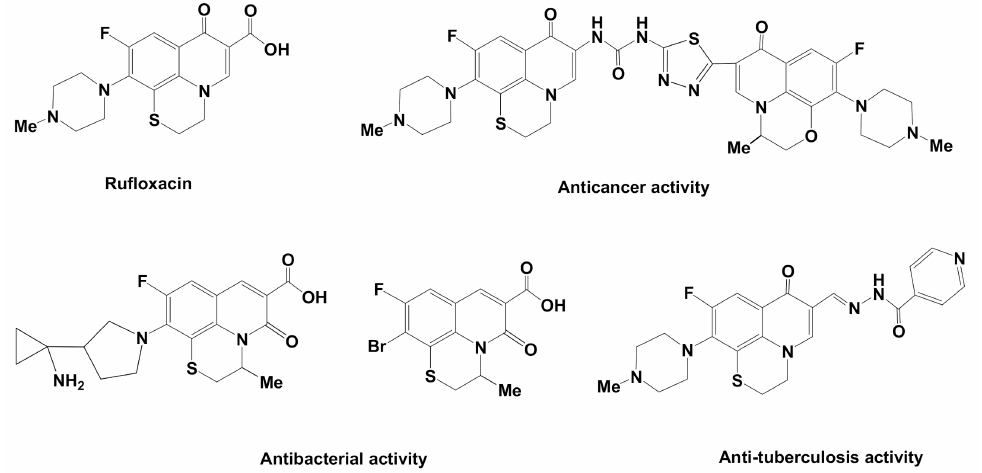
Figure 1. Known biologically active compounds containing 2 H ,3 H -[1,4]thiazino[2,3,4- ij ]quinolin-4- ium scaffold (anticancer [18], antibacterial [19] and antituberculosis [20]